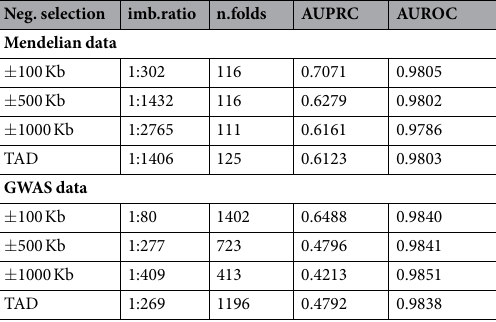
Neg. selection imb.ratio n.folds